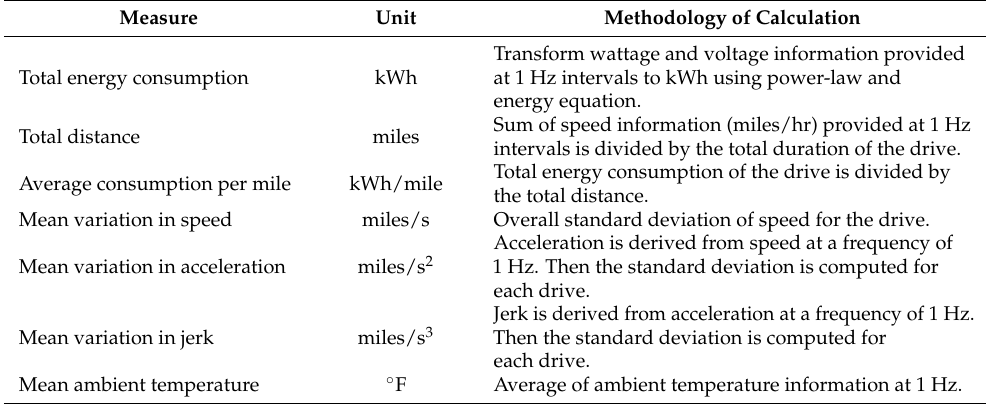
Table 1. Target measures and explanation of